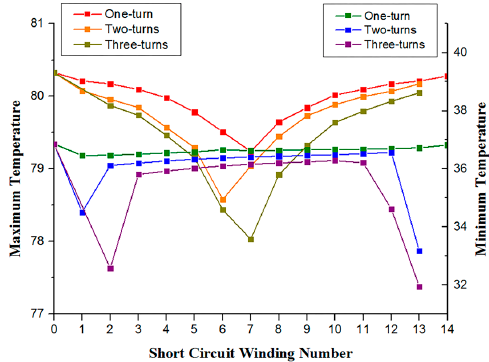
Figure 8. Multi-turn short circuit temperature change diagram.